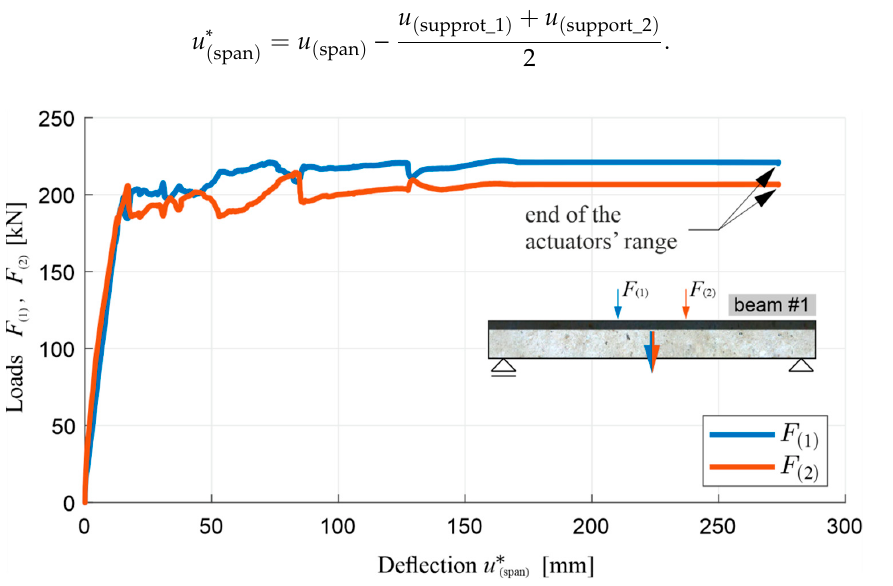
Figure 20. Load diagram in the function of the deflection at the middle of the span of beam #1, with the equal displacement of the actuators being forced.